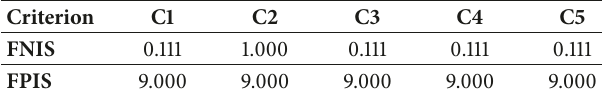
Table 6: Values of FNIS and FPIS. Table 7: Comparing the closeness coefficient of